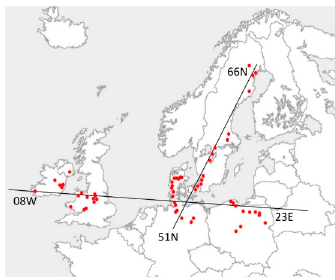
Figure 1. Collection locations of Dactylis glomerata in northwest Europe. Plants were sampled across east to west (2500 km) and north to south (3000 km)